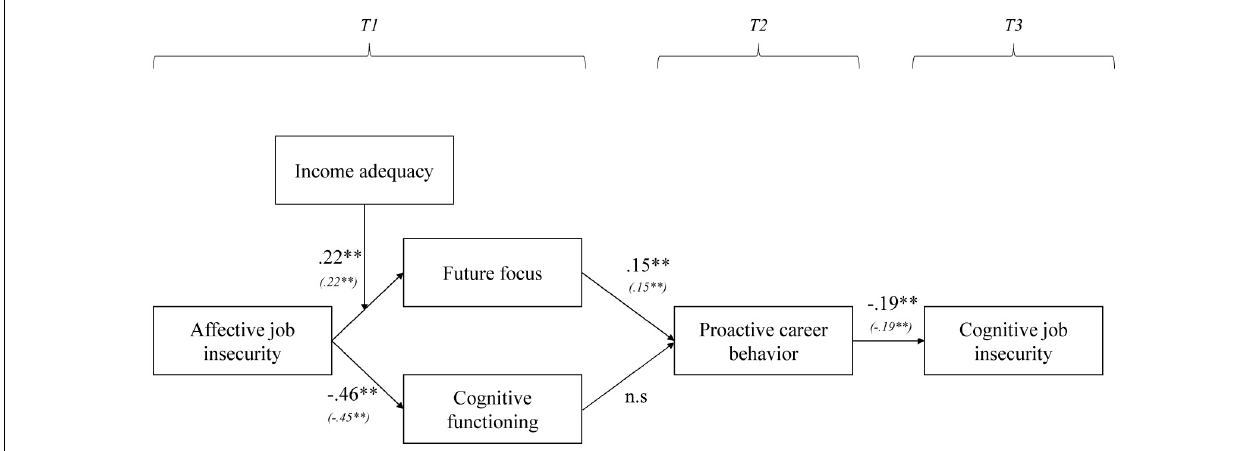
FIGURE 2 | Results of path modeling. Proactive career behavior (T2) and cognitive job insecurity (T3) were controlled for their associated level at T1. The hypothesized model was also tested with the demographic control variables age, gender, level of education, and financial buffer as covariates of all Time 1 variables. The results of the model with demographic control variables ( χ 2/ df = 2.16, p = 0.00, CFI = 0.89, RMSEA = 0.06) are displayed between brackets.